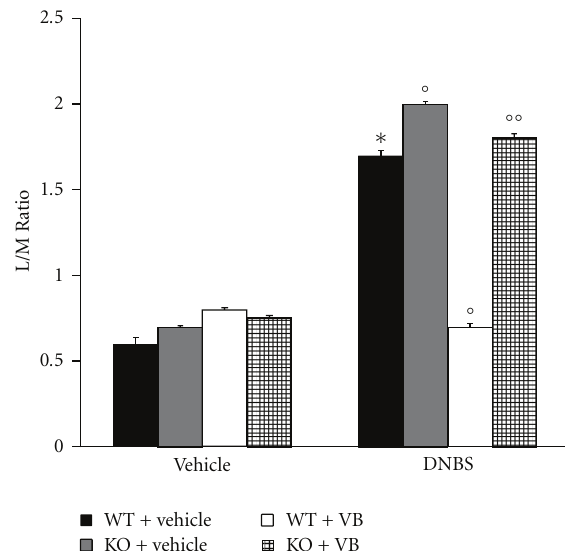
Figure 6: E ff ects of PPAR- α on intestinal permeability. Permeability probes (lactulose and mannitol) were administered by gavage, and urinary lactulose and mannitol excretion were measured in urine collected over a 4- to 5-hour postgavage period, and L/M ratios were calculated. The L/M ratio was unchanged in the sham- treated mice. On the contrary, at 4 days after colitis, the L/M ratios were significantly higher in the urinary samples from DNBS- treated PPAR- α WT mice in comparison with the sham animals. The absence of a functional PPAR- α gene in PPAR- α KO mice resulted in a more pronounced increase of L/M ratios. Treatment with VB significantly reduced the increased L/M ratios, while the absence of PPAR- α gene significantly abolished the e ff ect of VB. Data are means ± SEM of 10 mice for each group. ∗ P < . 01 versus sham; ◦ P < . 01 DNBS